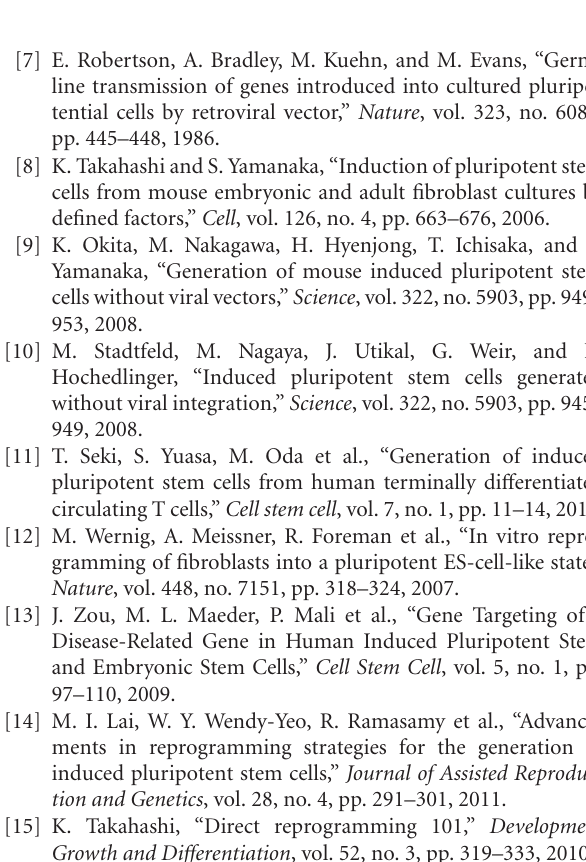
Figure 4: MicroRNA applications for iPS-mediated human disease mouse